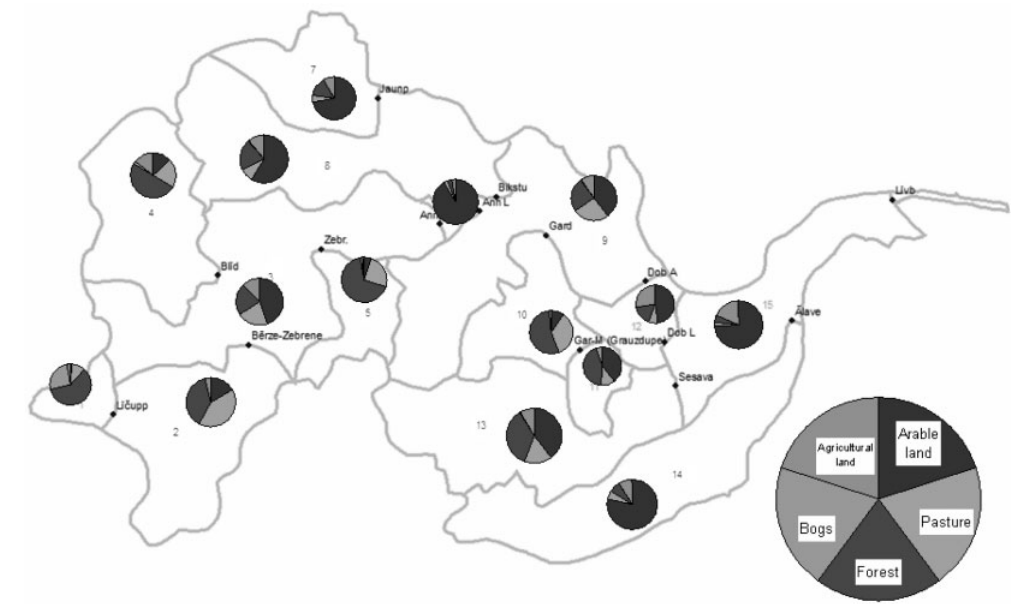
Fig. 10. N tot diffuse source apportionment in Be¯rze River subcatchments (2000 (cid:2) 2010)